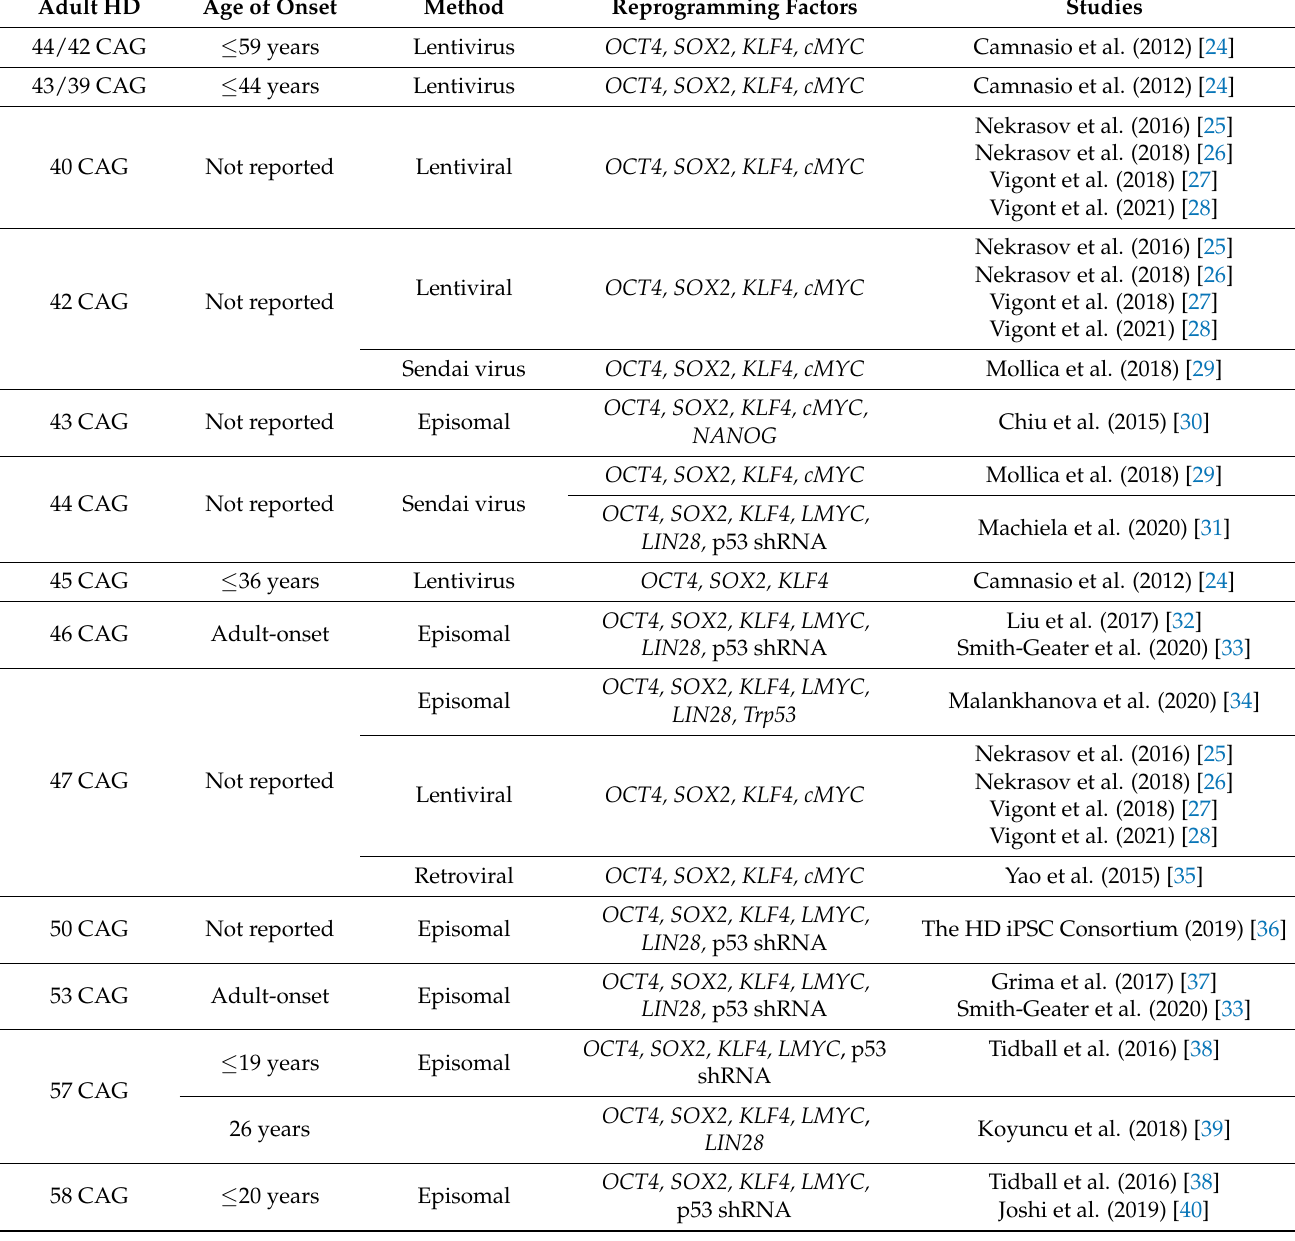
Table 2. Studies that have utilized human Huntington’s disease induced pluripotent stem